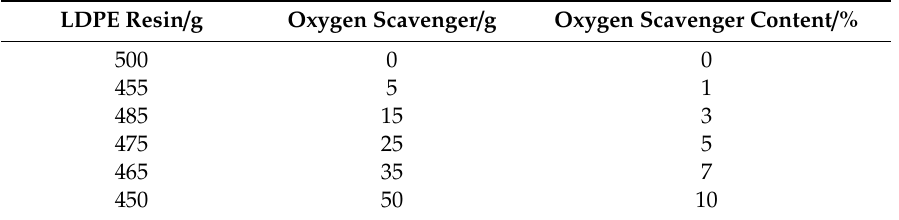
Table 1. Component of the oxygen scavenging film.